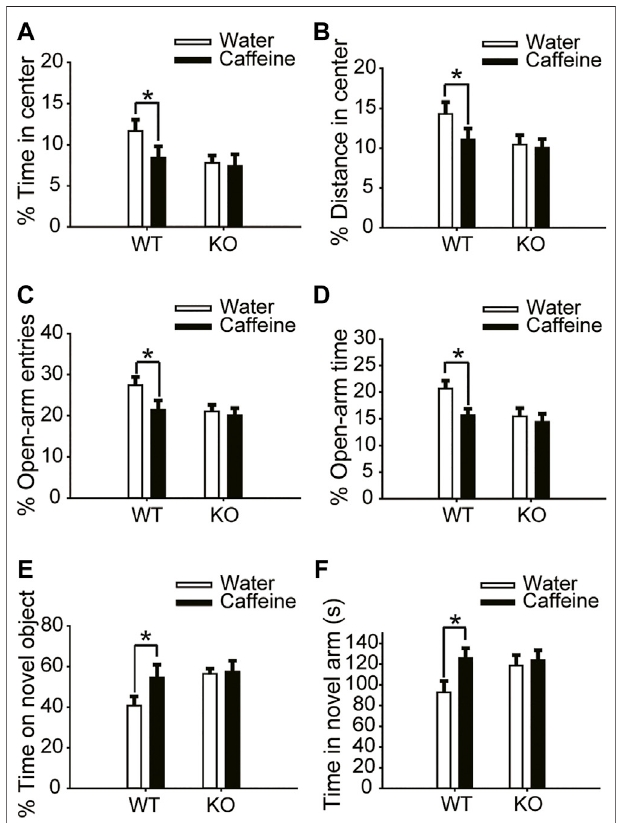
FIGURE 1 | Effects of chronic caffeine consumption on wild-type mice and A 2A Rknockout mice inbehavioral experiments. (A,B) Behavior ofthefour groups of mice in the open- fi eld test. Caffeine induced anxiogenic behavior with decreased time in the center (A) and distance in the center (B) in wild-type mice. (C,D) Behavior of the four groups of mice in the Elevated Plus Maze (EPM) test. Caffeine decreased the percentage of open-arm entries (C) and the percentage of time spent in the open arms (D) in wild-type mice. (E) Behavior of the four groups of mice in the Novel Object Recognition (NOR) test. The time spent exploring a novel object is shown as the ratio of the total time spent exploring both objects in the testing trial. (F) Behavior of the four groups of mice in the Y-maze test. The time spent in the novel arm is shown during the retrieval phase. Dataare presented as the mean ± SEM, n = 7 mice per group; * p < .05, two-way ANOVA, Bonferroni post hoc t-test.